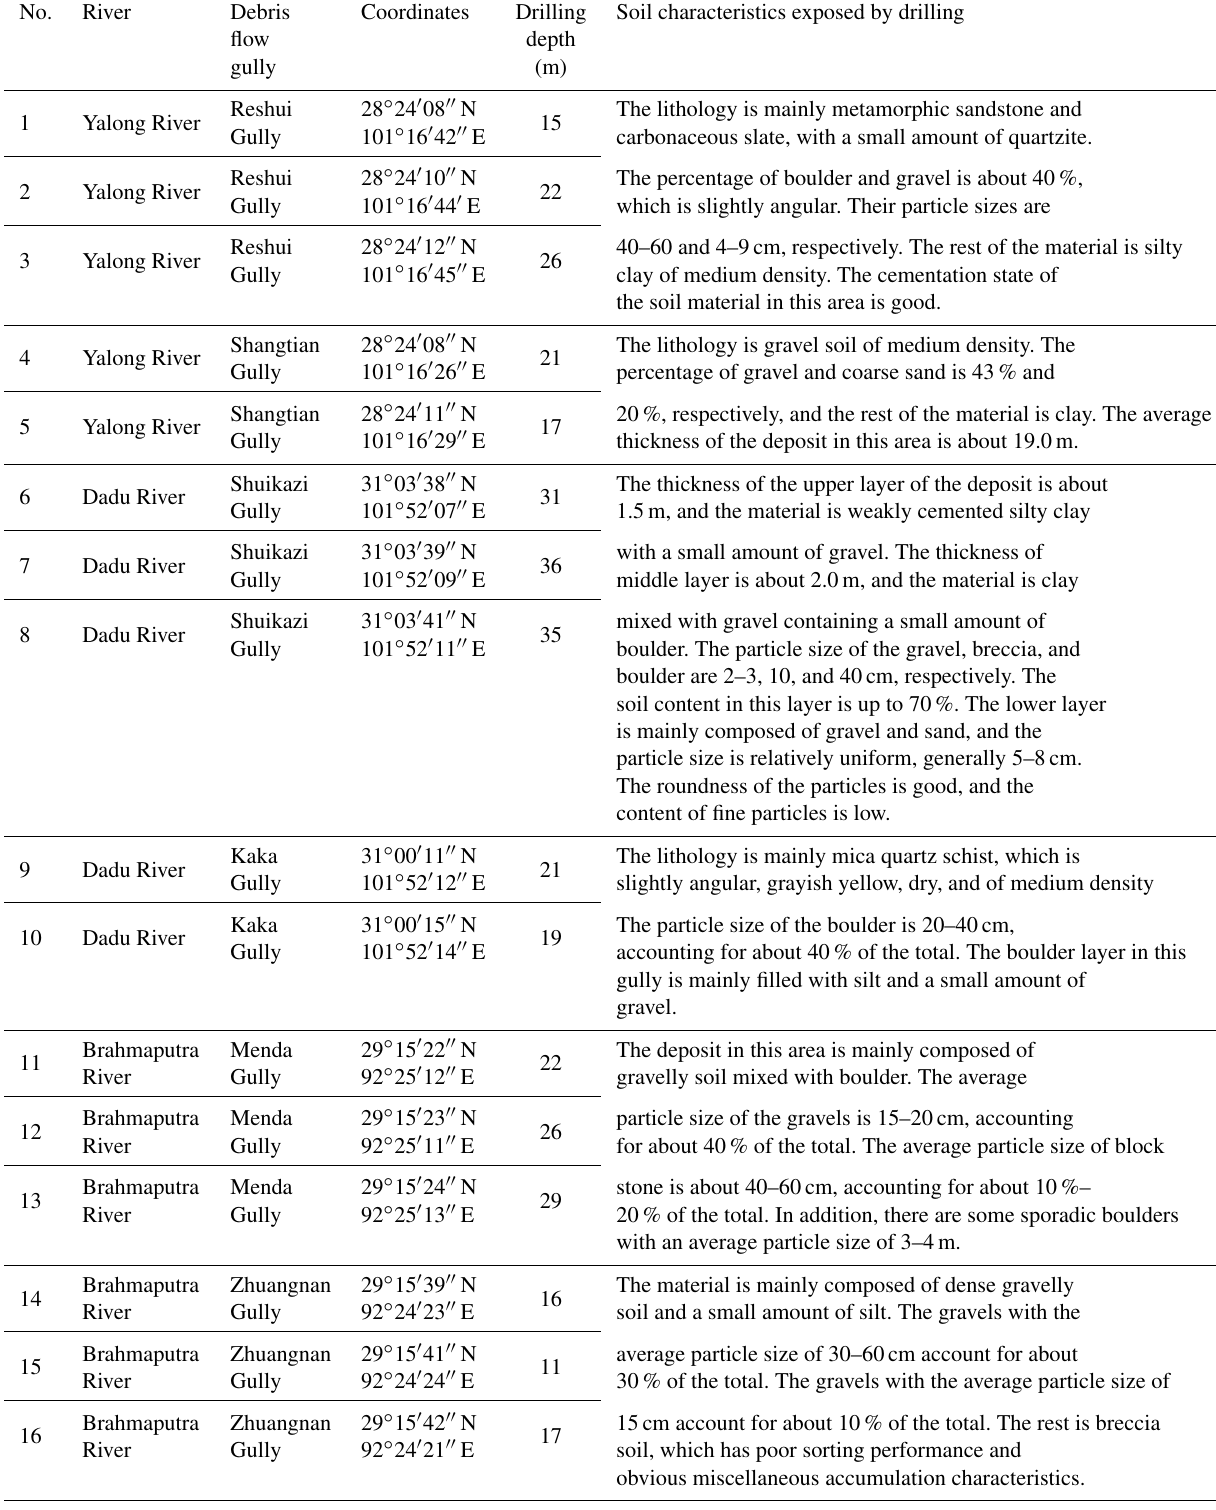
Table 2. Information and results of the geological drilling in the study area.